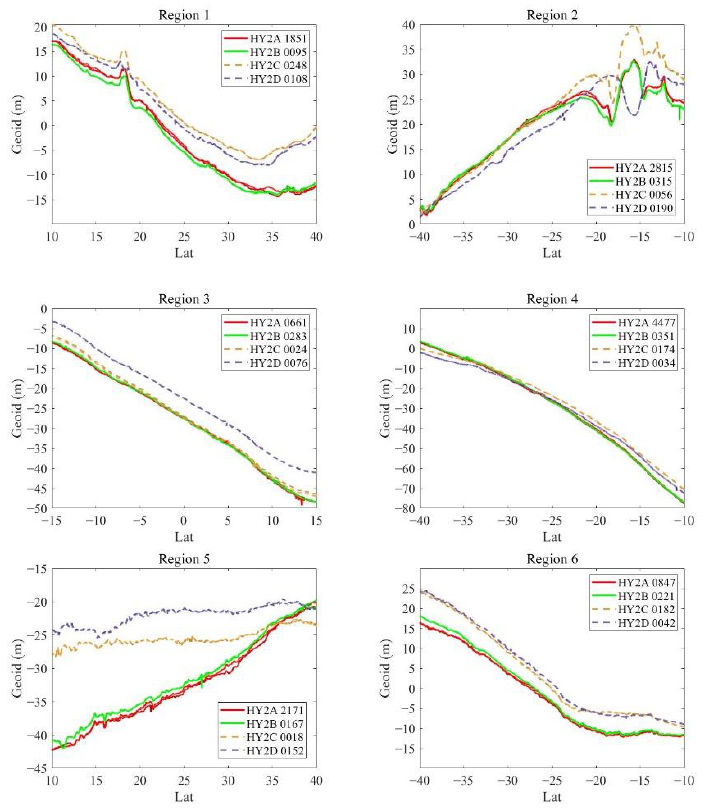
Figure 5. Variation trend of geoid heights along sample data sequences for HY-2A, HY-2B, HY-2C and HY-2D: Region 1, North Pacific; Region 2, South Pacific; Region 3, Mid-Pacific; Region 4, Indian Ocean; Region 5, North Atlantic; Region 6, South Atlantic.